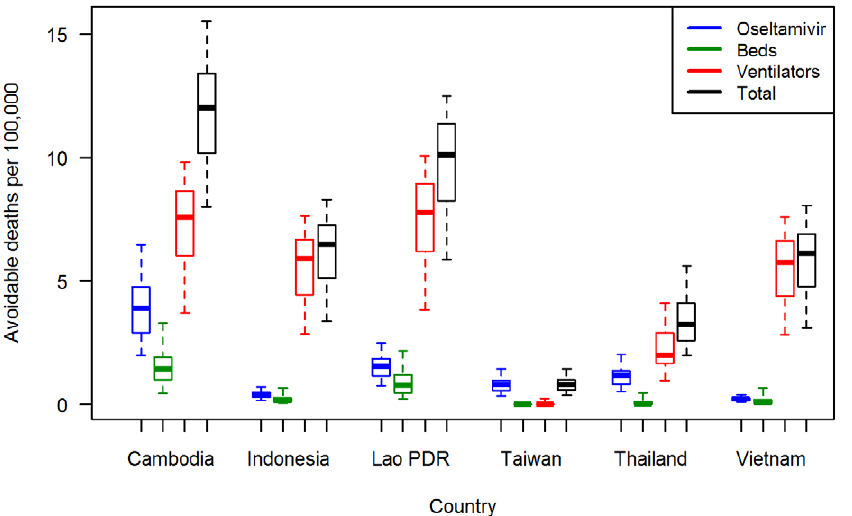
Figure 3. Estimated avoidable mortality rates due to each resource gap across countries for a modeled pandemic influenza scenario. Deaths attributed to shortages of oseltamivir, hospital beds, and ventilators are estimated from the number of deaths that the model predicts would be prevented by filling the gap in each of these resources alone. Boxplots show medians, interquartile ranges, and 95 th percentile ranges derived from a multivariate uncertainty analysis. Data are aggregated across provinces for Cambodia, Lao PDR, Thailand, Vietnam, and across counties for Taiwan. Data for Indonesia are aggregated across districts of Jakarta and Bali only.